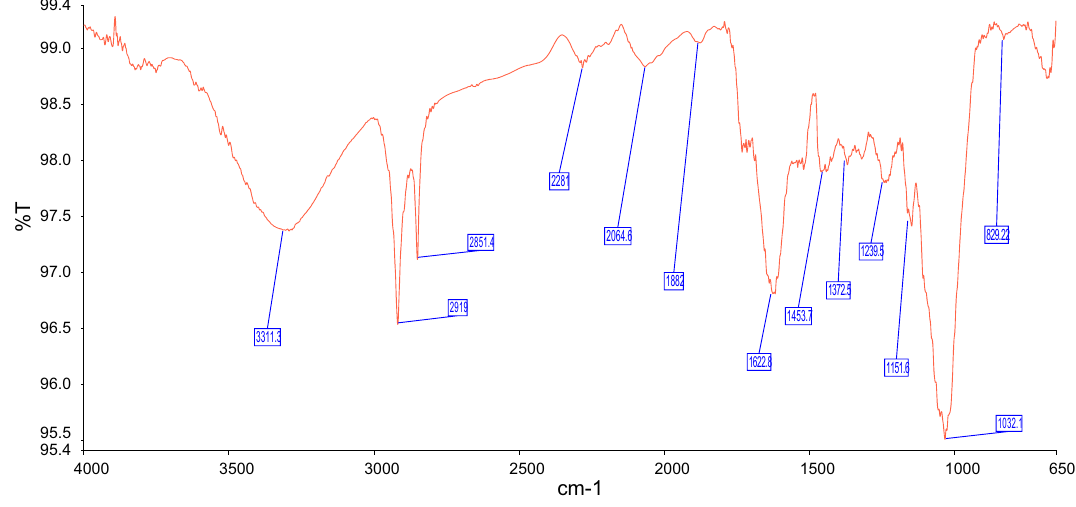
Fig. 8 FTIR spectra of waste tea leaves (Nur-E-Alam et al.